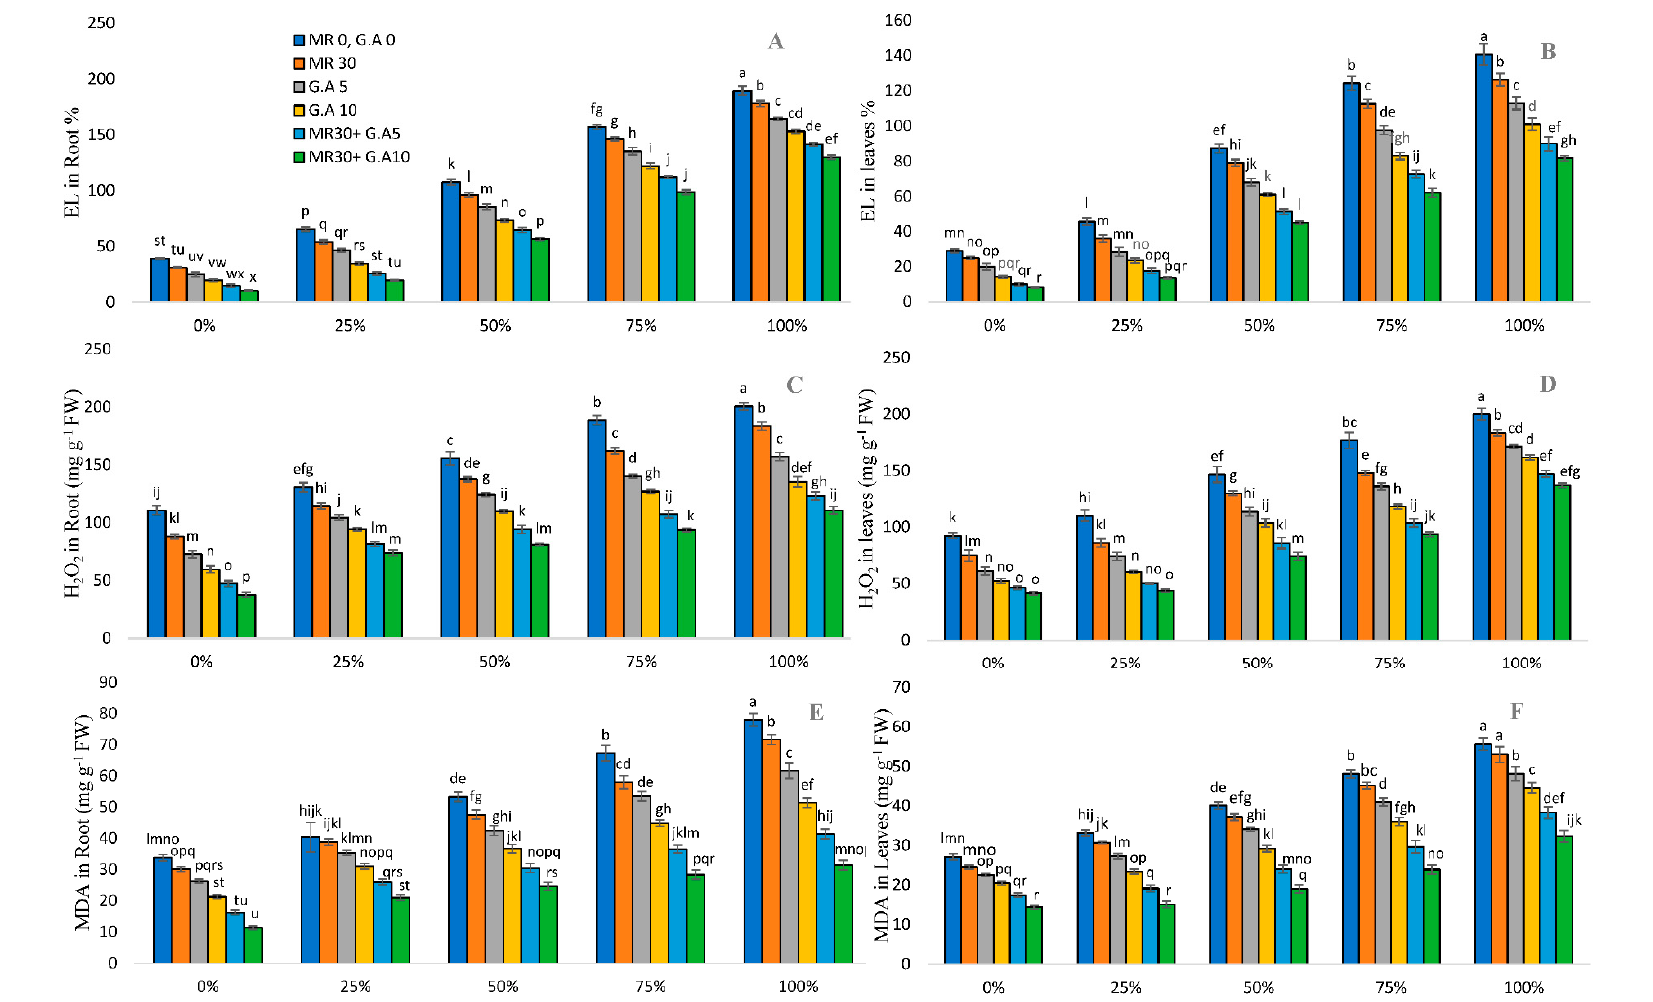
Figure 3. Surgical and textile effluent and glutamic acid effect on EL in root ( A ), EL in leaves ( B ), H 2 O 2 in roots ( C ), H 2 O 2 in leaves ( D ), MDA in roots ( E ), and MDA in leaves ( F ) in sorghum L . Values are demonstrated as means of three replicates along with standard deviation. Different small letters indicate that values are significantly different at p < 0.05 .